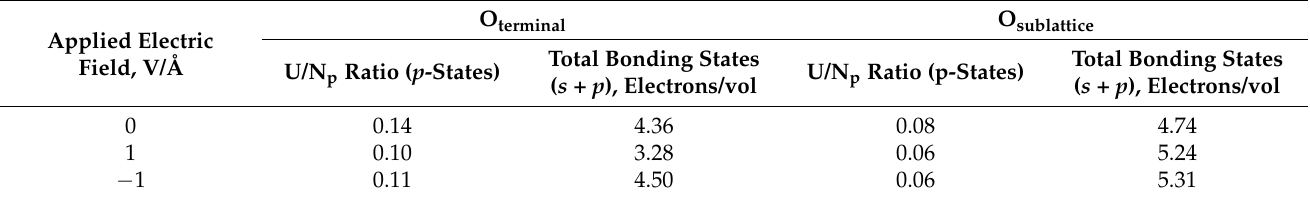
Table 3. Analysis of PDOS d -states at the O terminal and the O sublattice sites for applied field values of 0, +1, and − 1 V/Å. Applied Electric